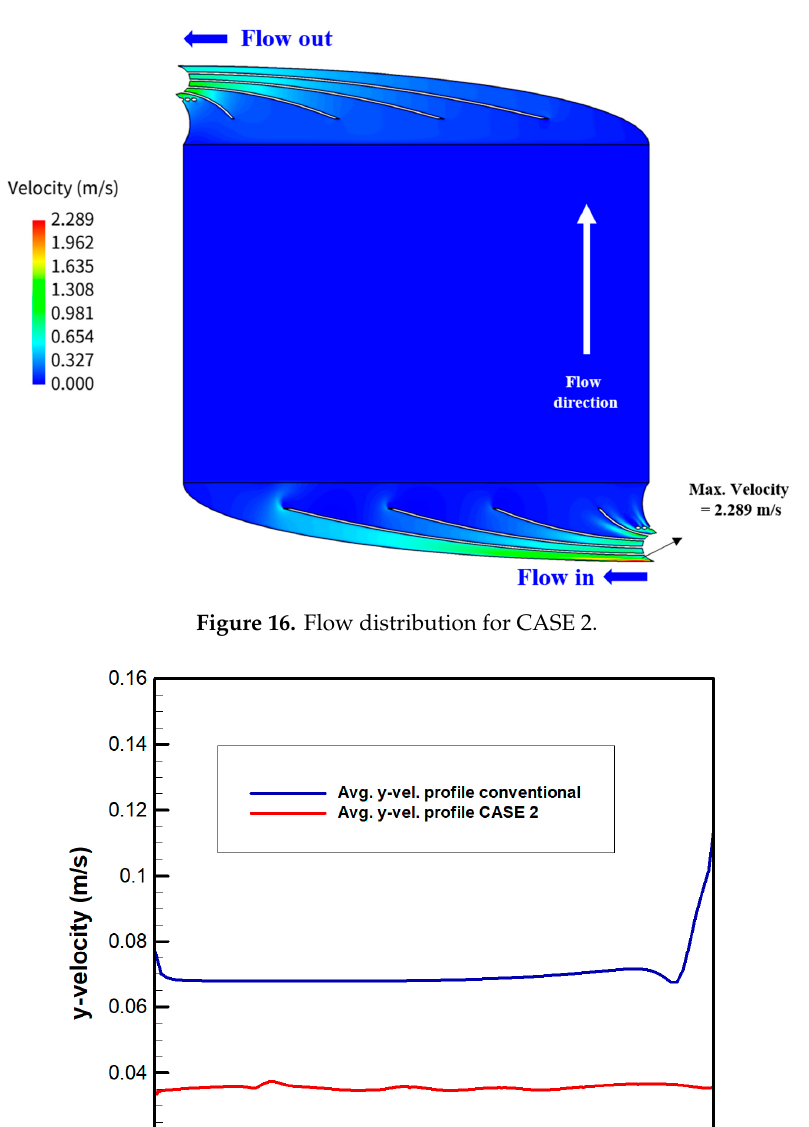
Figure 15. Velocity distribution at the electrode inlet for CASE 1 (location A).